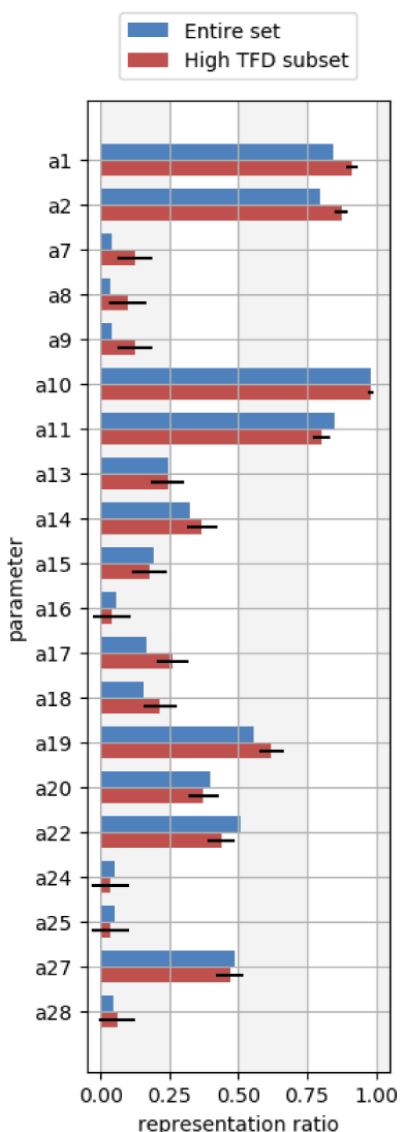
Figure 6. Prevalence of a subset of angle parameters used in the OpenFF-1.2 force field as calculated by Equation 4. The blue bars represent the parameter ratios from the full molecule set, and the red bars represent the parameter ratios from only the set of molecules with TFD values greater than 0.12. Error bars denote the 95% confidence interval determined from the one-sample Z-test for proportions. Parameters which are estimated to be overrepresented in molecules with high TFDs have statistically significant differences between the full set and high TFD set of parameter ratios (also see Table 2 ). Parameters with statistically significant differences in this plot are a1, a2, a7, a8, a9, a17, a18, and a19.